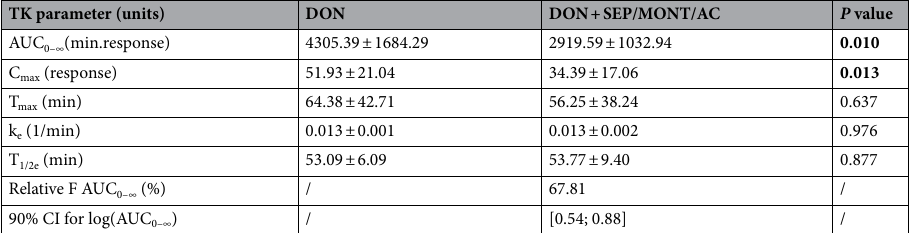
Table 1. Toxicokinetic (TK) parameters of the metabolite DON-S after oral administration of DON alone (0.5 mg/kg BW) and DON in combination with the detoxifier (0.4 g/kg BW, inclusion rate of 4 kg/t) to 8 broiler chickens. The mean ± standard deviation (SD) is shown. Significant values are in bold. AUC 0–∞ area under the DON-S response-time curve from time 0 to infinity, C max maximum DON-S response in